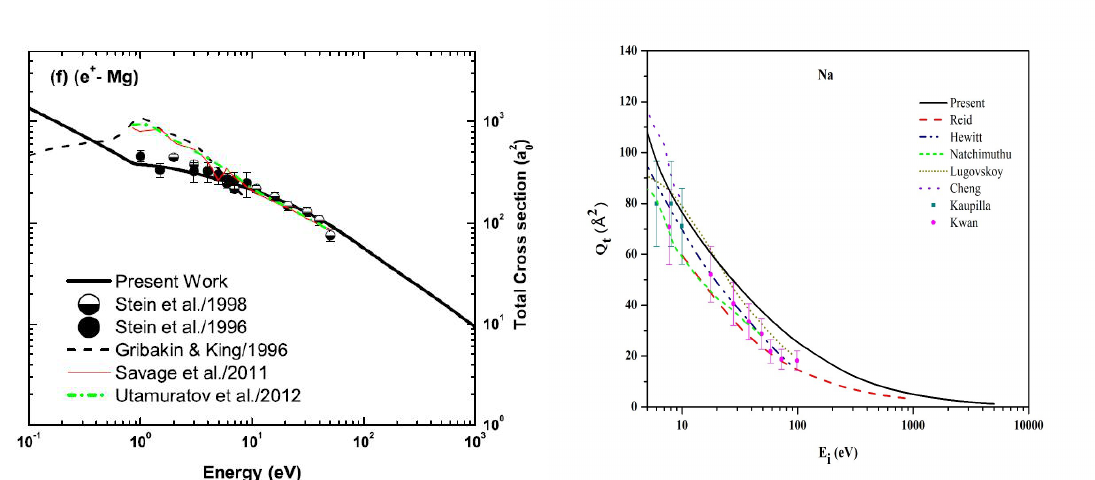
Figure 6. Left : Comparison of predicted total integrated cross sections for scattering of positrons from magnesium obtained by Hossain et al. [10] using optical potential similar to the present work show good agreement with experimental values. Right : Total cross section for e + -Na interaction